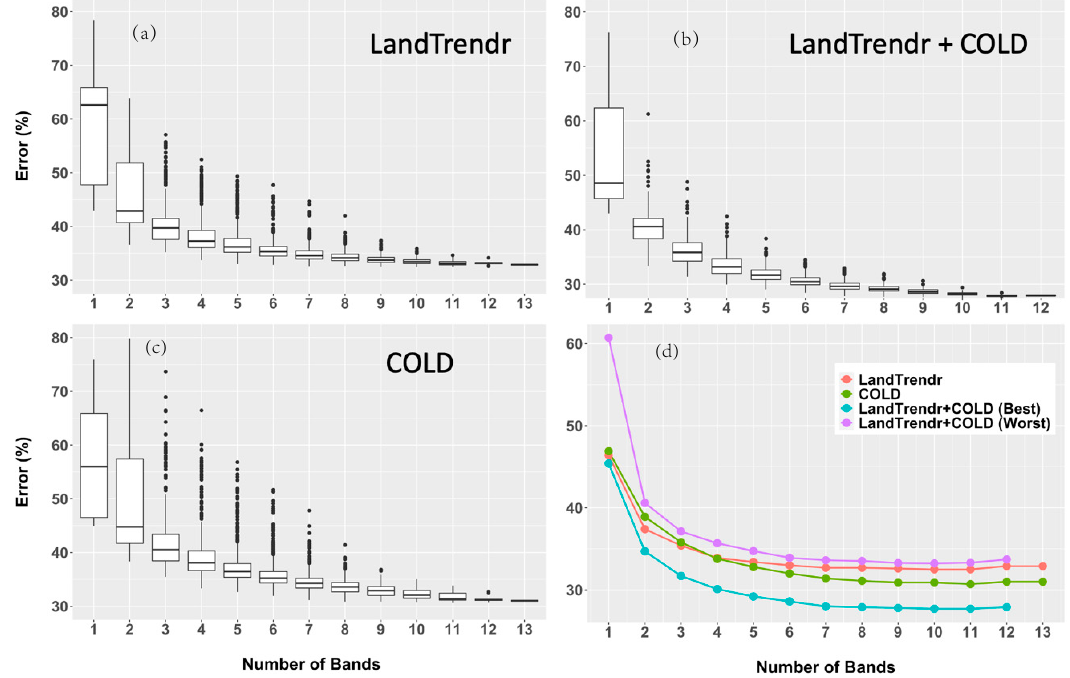
Figure 2. Distributions of balanced omission and commission errors among all combinations for each number of bands used, for ( a ) LandTrendr, ( b ) COLD, and ( c ) their combination. Also shown are the mean errors for the top five models of each modeling set, including those from the best and worst six bands for the combined models ( d ). Note that, for all modeling sets, error balances were achieved using probability thresholds of considerably less than 0.5, increasing and converging at approximately 0.3 as number of bands approached 4 or greater.